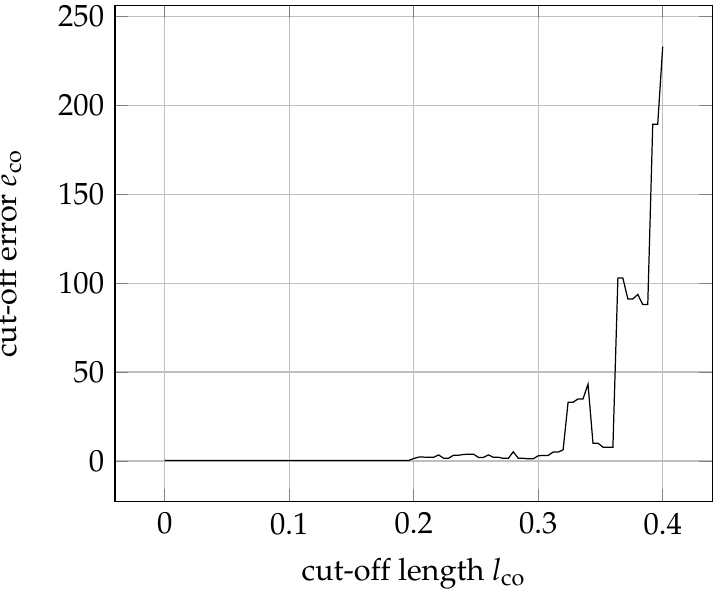
Figure 10. L 2 prediction errors in the parameter space for oPOD foreground POD+I with increasing snapshot reconstruction size for p d = ON.